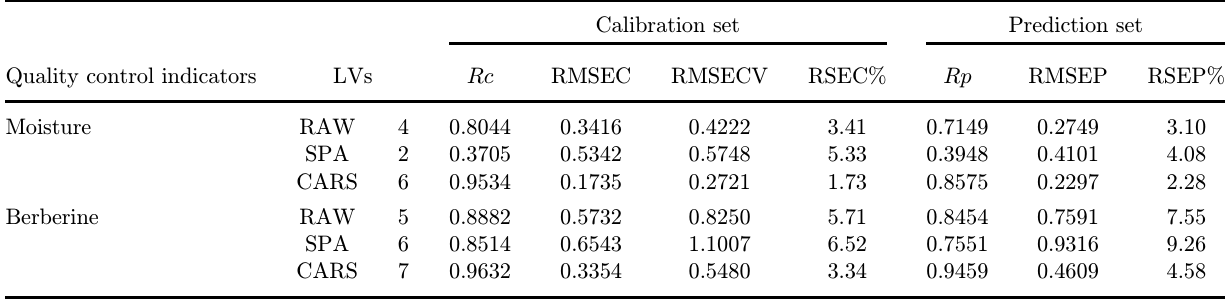
Table 3. Modeling results for single species model of PC.